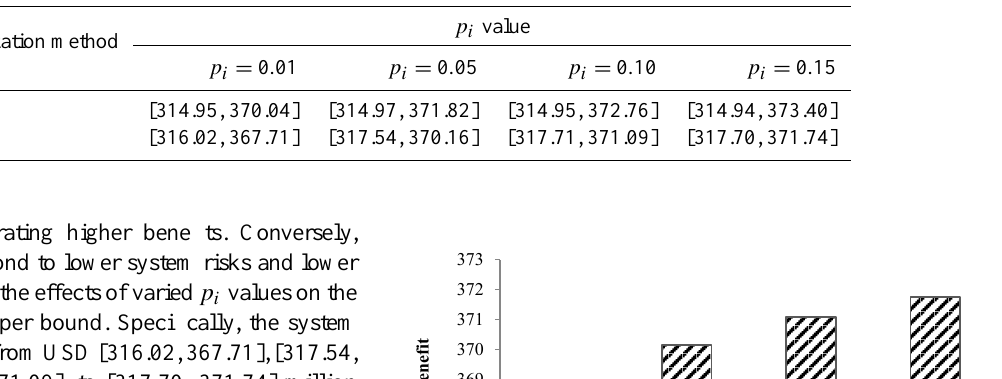
Table 8. System benefit from ICCP and DIFSP (USD million).